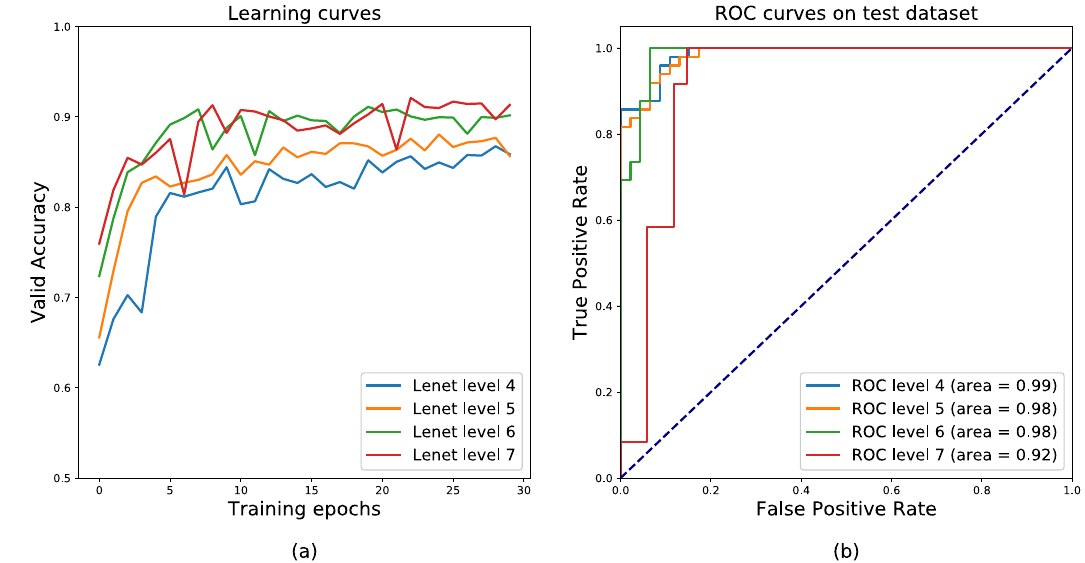
Fig. 2 Learning and fi nal ROC curves for slide diagnosis. a The model learns relevant information for patch classi fi cation as the patch level accuracy on the validation set increases with the number of learning iterations, at different resolution levels (7.84 µm/pixel to 62.72 µm/pixel). b Final ROC curves showing that the area under the curve (AUC) depends on the resolution level and could reach 0.99. Best slide diagnosis integration is obtained from patch classi fi ers with the smallest validation accuracy: at high resolution (pyramid level 4) more independent/ non-overlapping patches are extracted and predicted, resulting in a more robust average